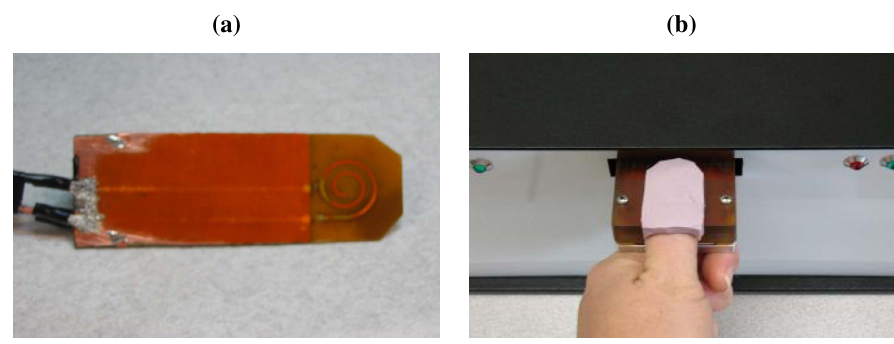
Figure 3. (a) Initial design of microwave sensor (b) Modified microwave sensor with silicon positioning aid